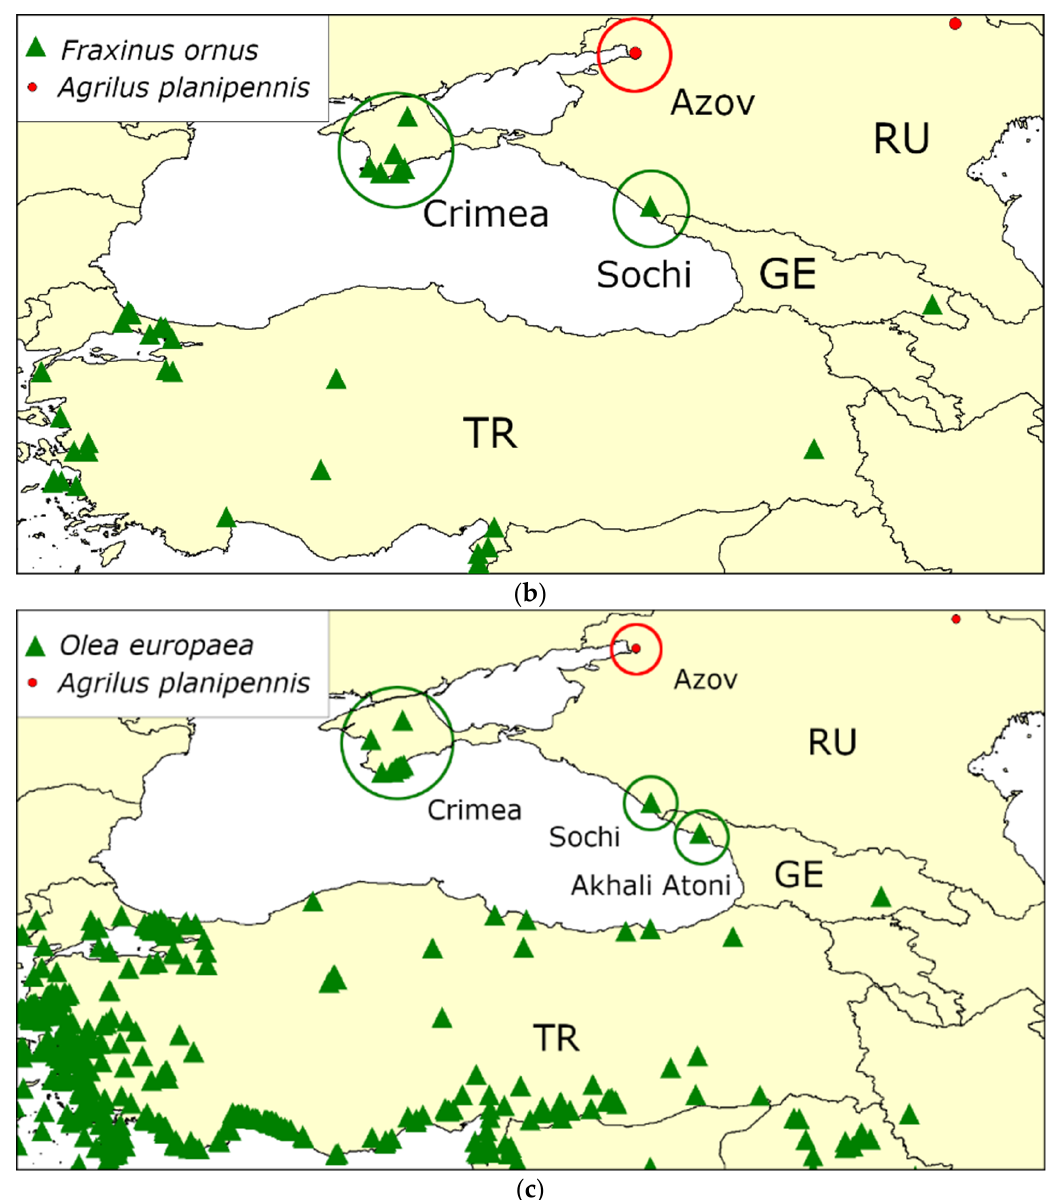
Figure 6. Sentinel trees of F. angustifolia ( a ), F. ornus ( b ) and Olea europaea ( c ) in the Black Sea Region close to the current range of A. planipennis .